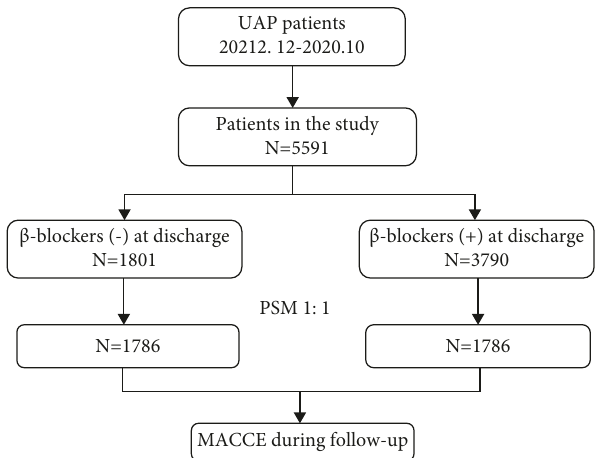
Figure 1: Flow chart of patient inclusion. UAP, unstable angina pectoris; MACCE, major adverse cardiac and cerebral